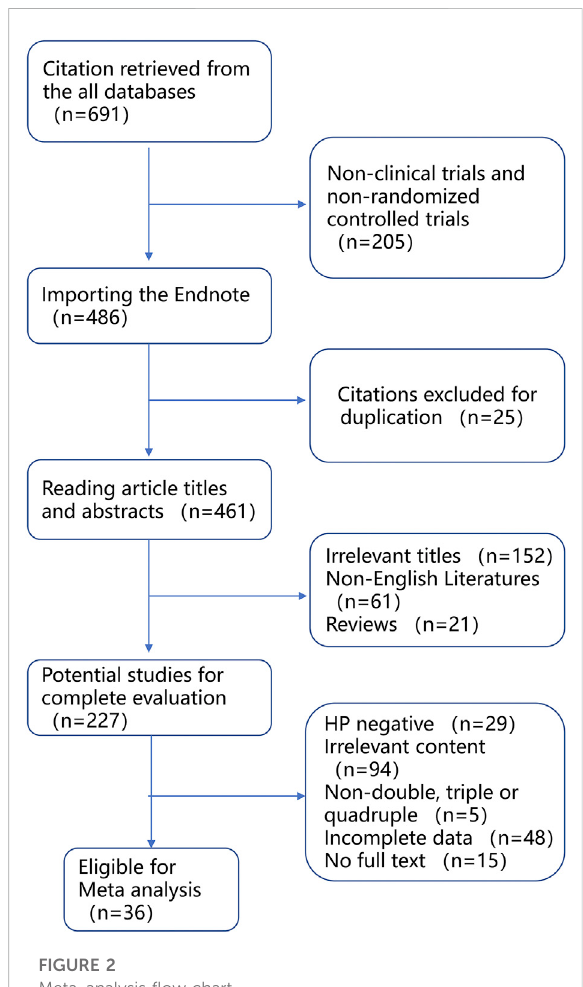
FIGURE 2 Meta-analysis fl ow